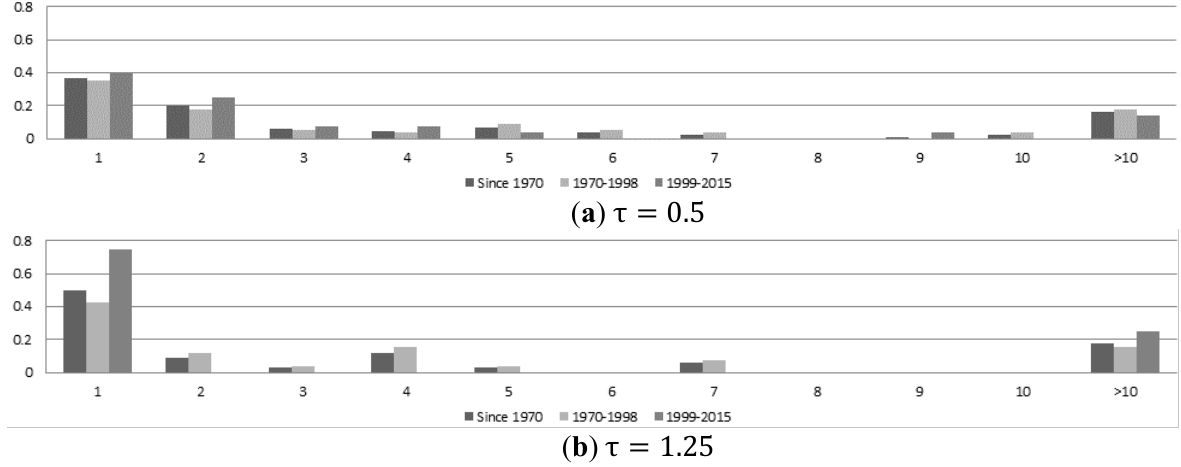
τ = 1.25 Figure 8. Fraction of systemic stress episodes with the given durations (measured in weeks)